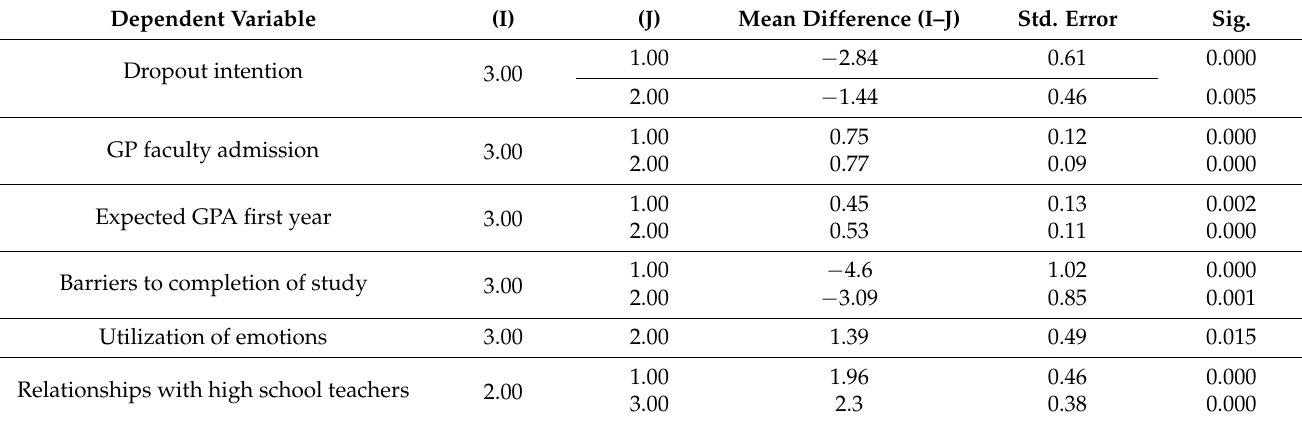
Table 3. Differences depending on achievement levels at the end of first year (H1.3b).